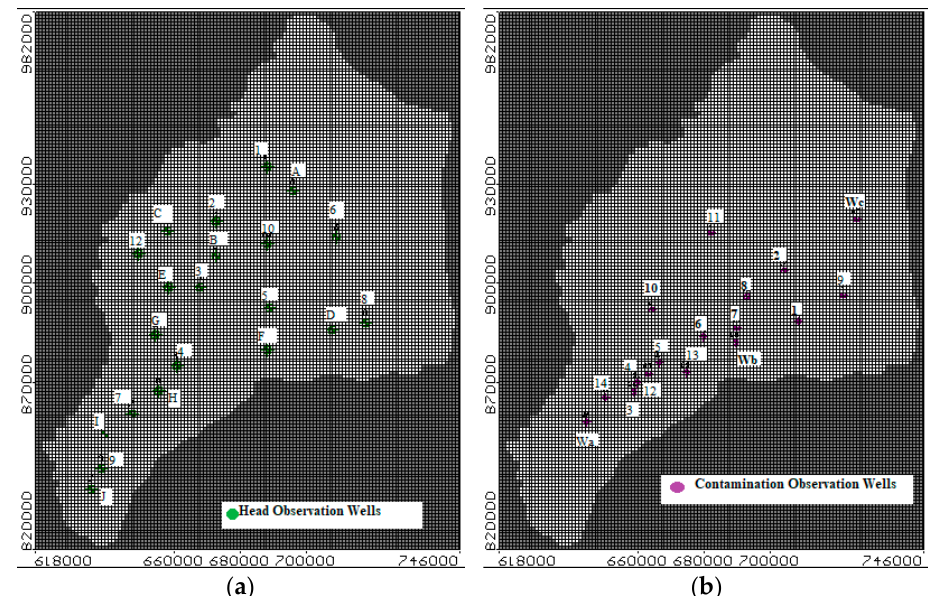
Figure A2. Location map of pumping wells distribution in the ENDA.